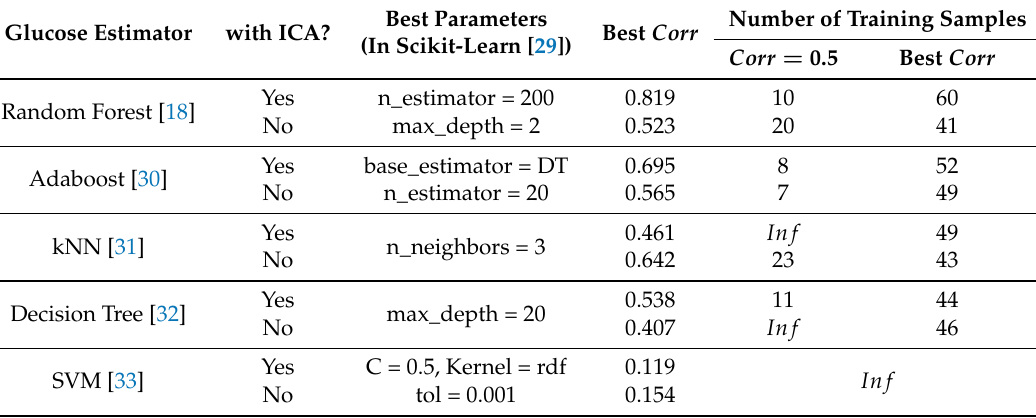
Table 2. Comparative experiment results of various regression